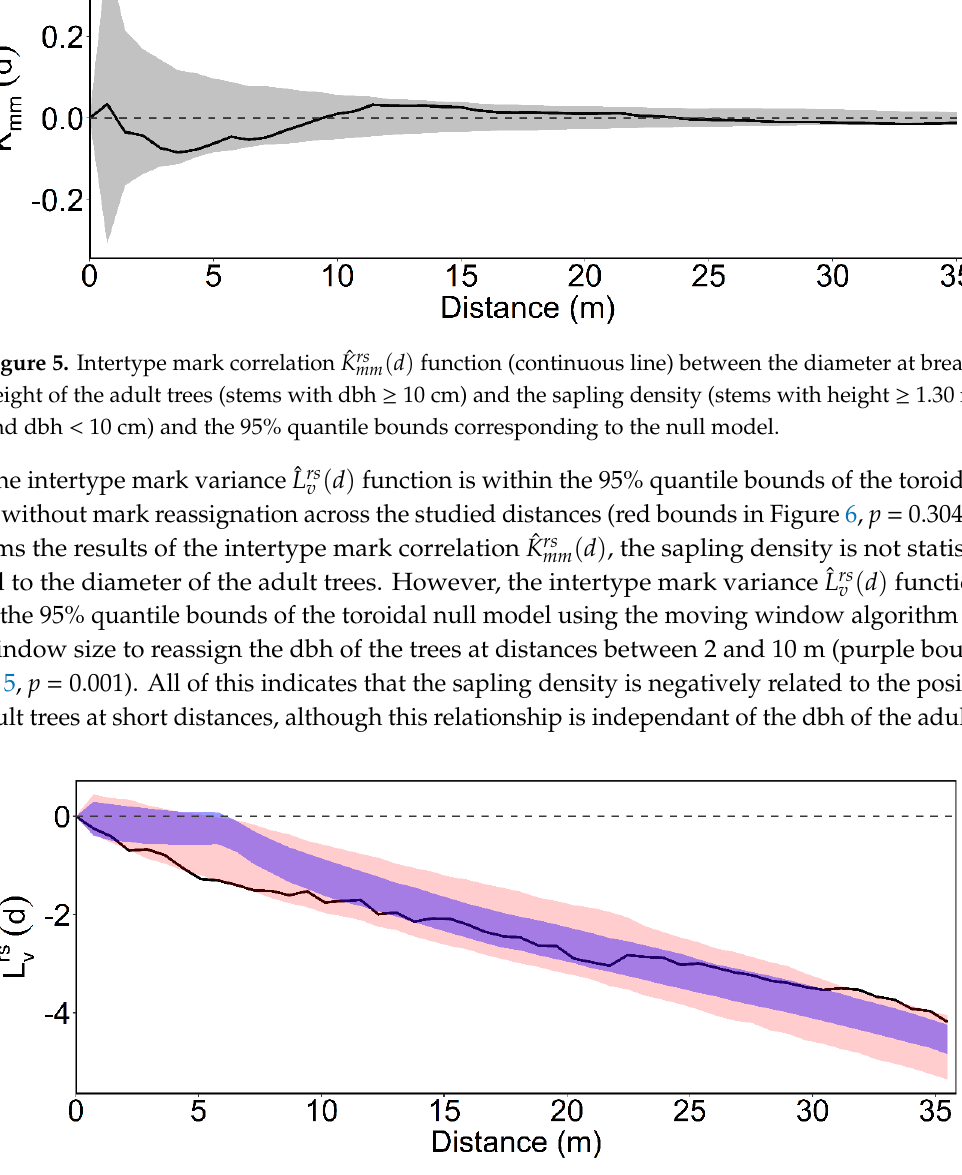
Figure 6. Intertype mark variance ˆ L rs v ( d ) function (continuous line) between the diameter at breast height of the adult trees (stems with dbh ≥ 10 cm) and the sapling density (stems with height ≥ 1.30 m and dbh < 10 cm) and the 95% quantile bounds corresponding to the toroidal shift null model (red bounds) and to the toroidal shift null model using the moving window approach (purple bounds).